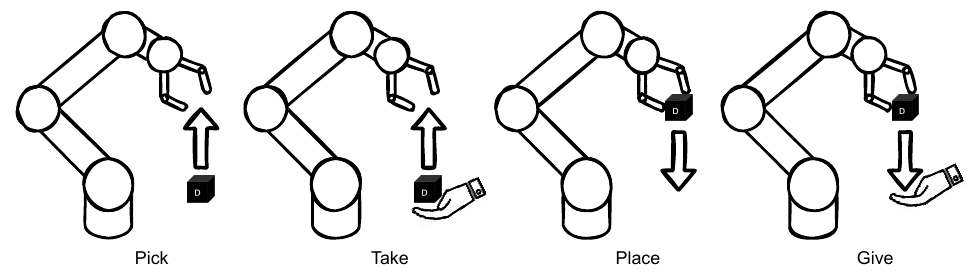
Figure 6. Basic robot operations: Pick up, take from user, place on table, and give to